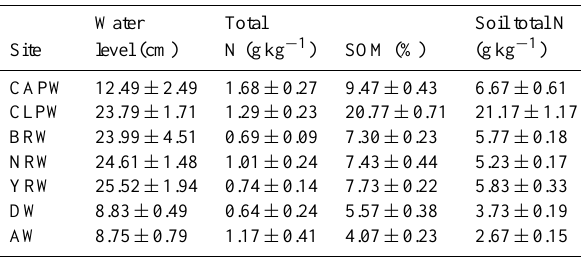
Table 1. Characteristics of the seven studying sites in the Sanjiang Plain, Northeastern China.